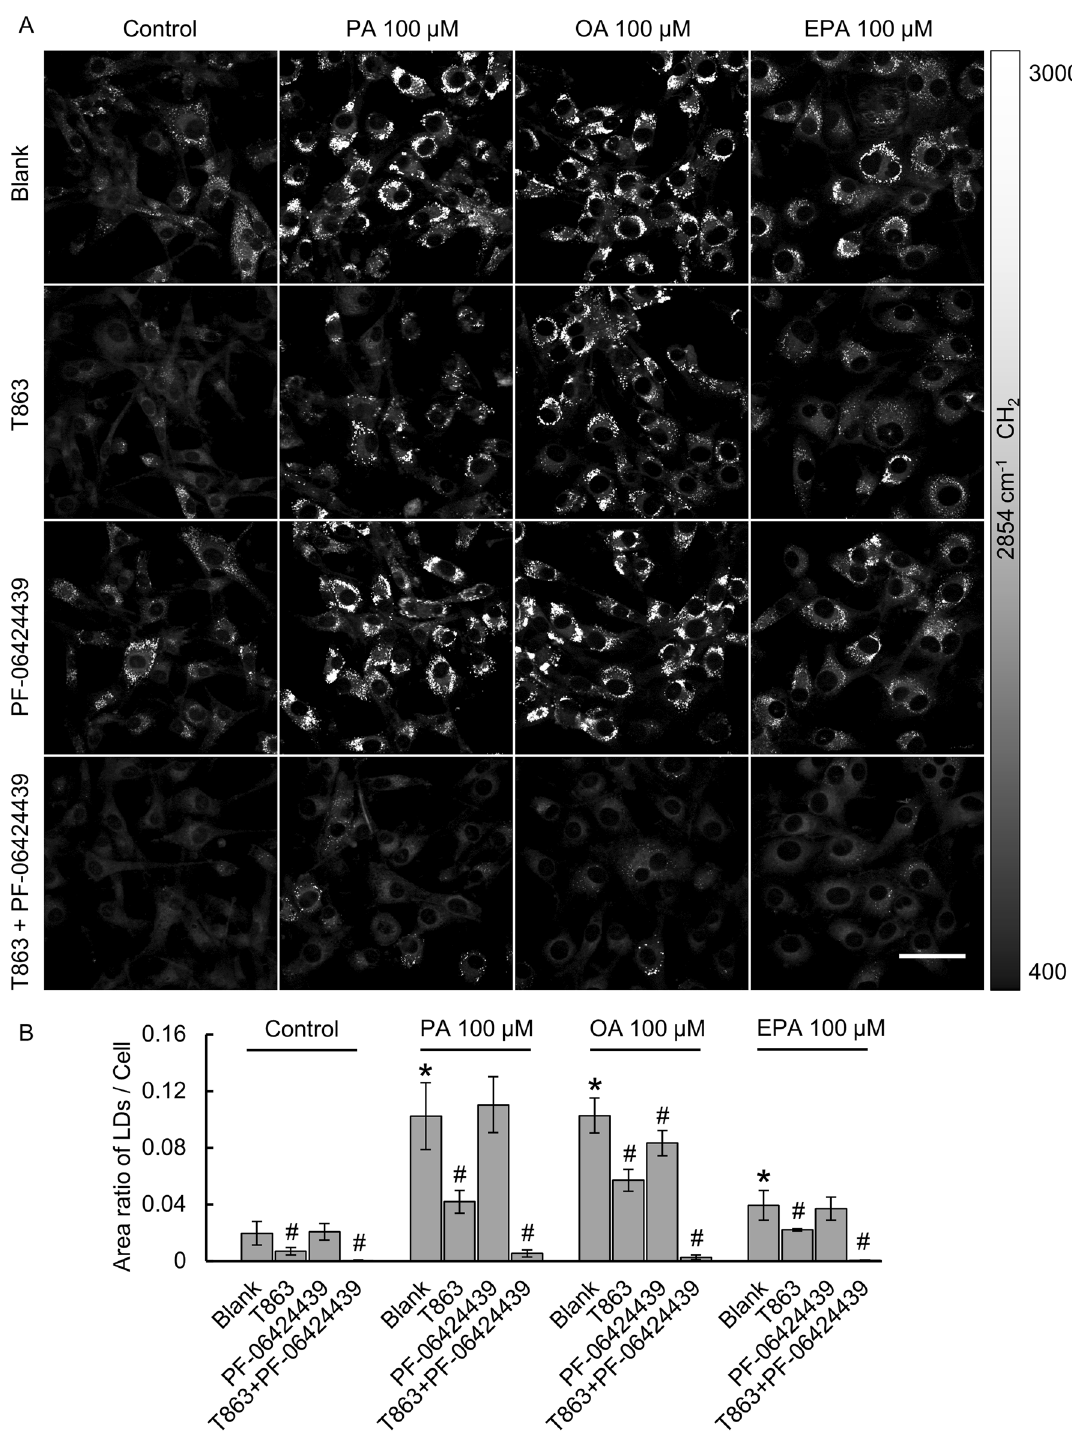
Figure 6. ( A ) SRS imaging of LDs at 2854 cm −1 under various culture conditions. U87 glioma cells were treated with PA, OA, and EPA at 100 μM for 24 h. DGAT1 and DGAT2 are essential enzymes for LDs synthesis in U87 cells. DGAT1/2 were inhibited by T863 (20 µM) and PF-06424439 (10 µM). Scale bar, 50 μm. ( B ) Quantification of total LDs using the area-ratio method for each experimental group with SRS images at 2854 cm −1 . *P < 0.05, the difference is statistically significant from blank in the control group. # P < 0.05, the difference is statistically significant from blank in control for all PA-, OA-, and EPA-treated